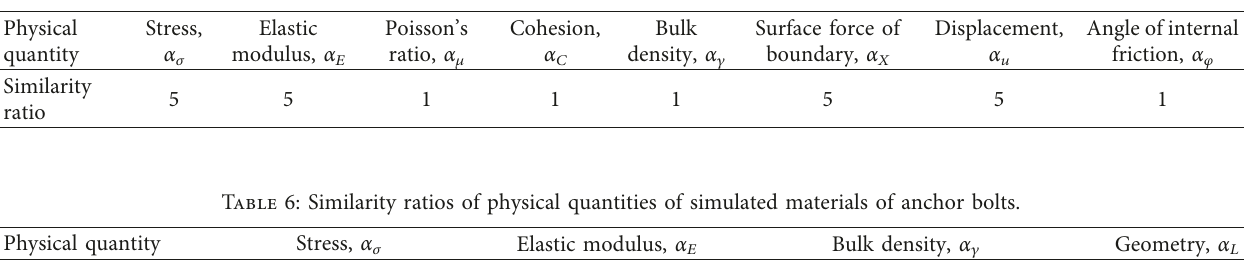
Figure 12: Total energies in wavelet frequency bands under different confining pressures. (a) Horizontal direction. (b) Vertical direction. Table 5: Similarity ratios of physical quantities of simulated materials of rock.